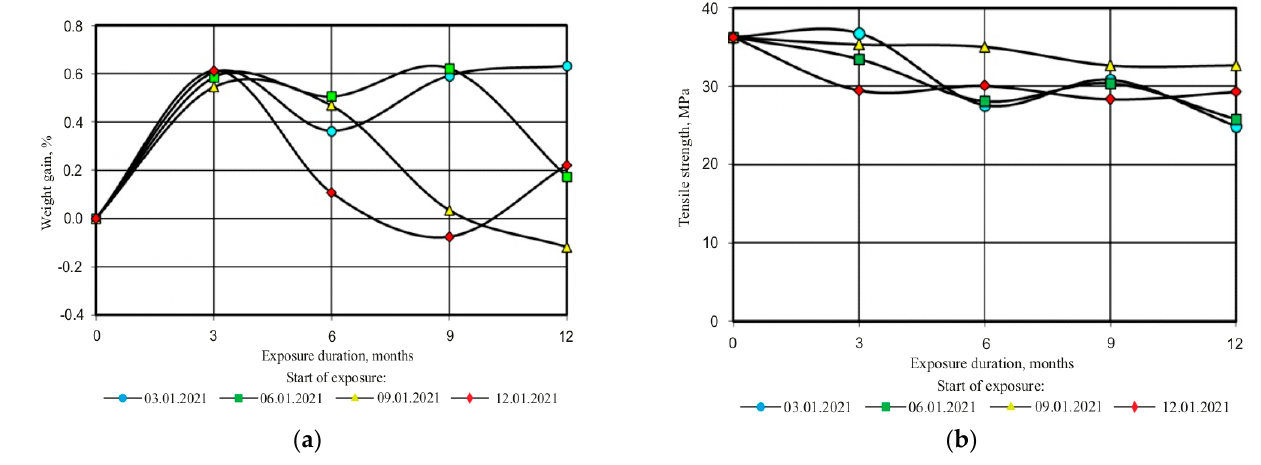
Figure 12. Changes in mass ( a ) and tensile strength ( b ) of samples of the composition Etal ‐ 247 + Etal ‐ 45M depending on the season of the start of exposure.